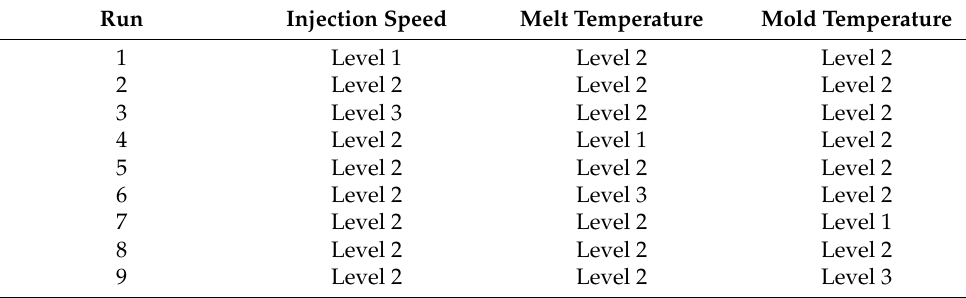
Table 2. One-factor-at-a-time experimental design.